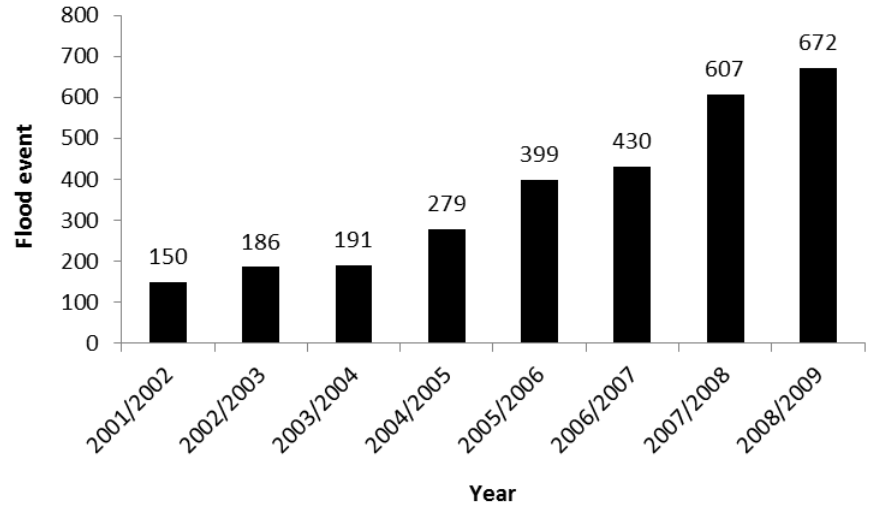
Figure 1. Flood events during the period of